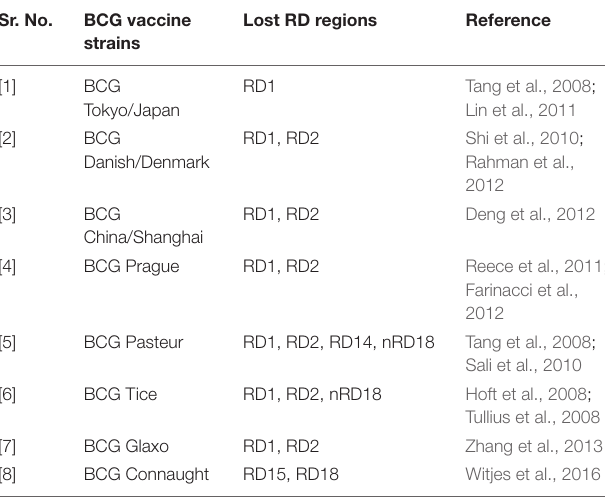
TABLE 1 | Different BCG vaccine strains available